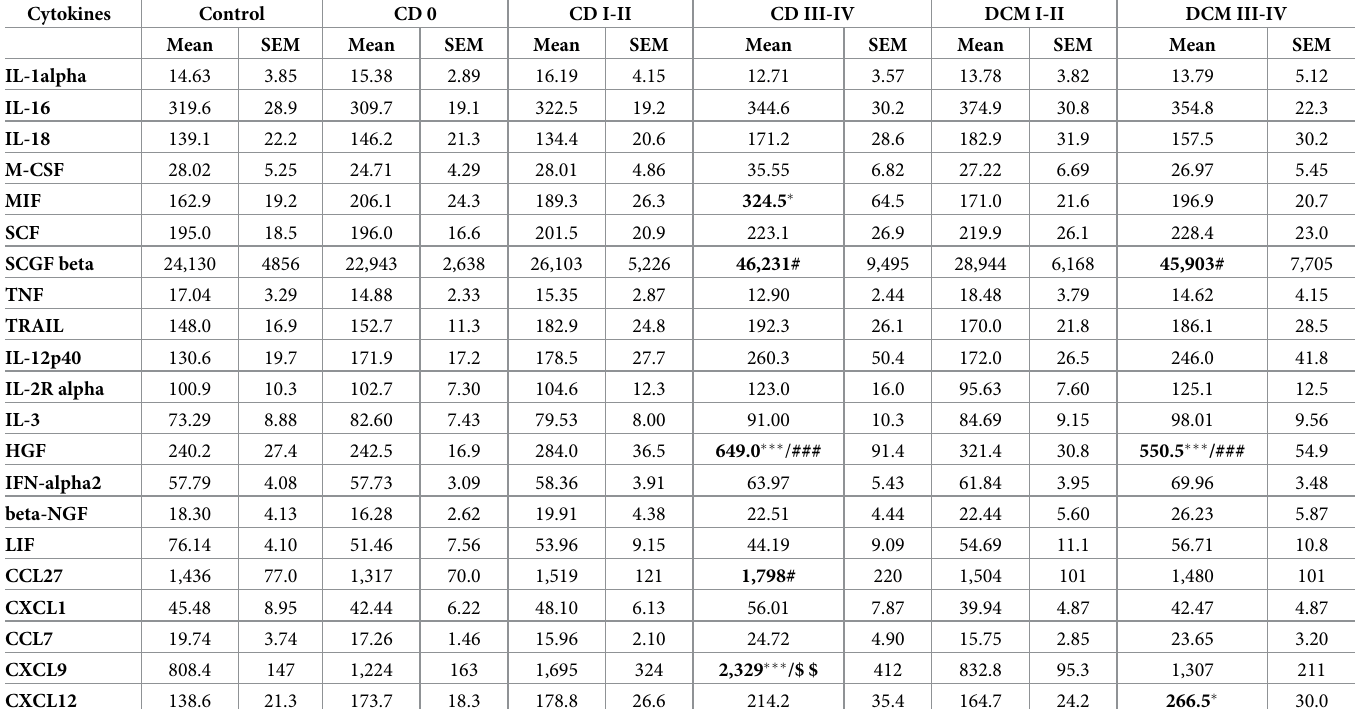
Table 2. Plasma concentrations of cytokines in control, CD, and DCM groups expressed as mean ± standard error of the mean (SEM). Cytokines Control